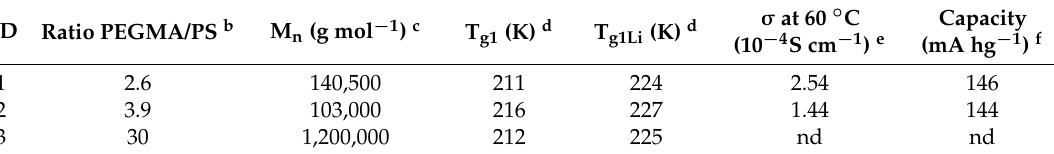
Table 1. Polymer Characteristics. a